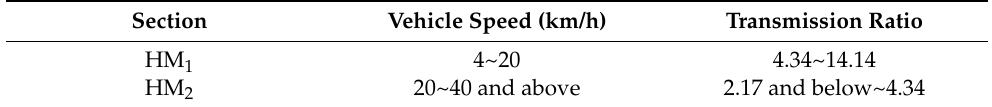
Table 2. Transmission ratios of HMCVT’s sections for